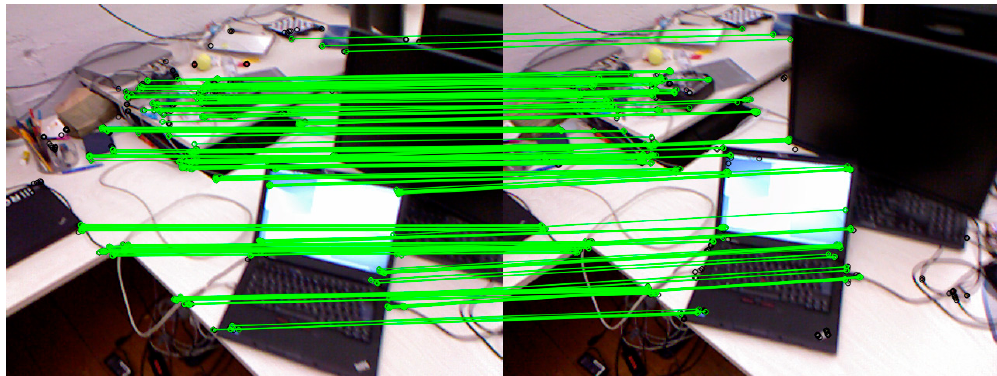
Figure 7. Good matching points of the acquired query image and the retrieved database image.